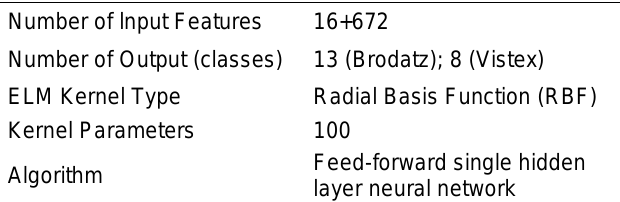
Table 1. Working parameters of the proposed technique